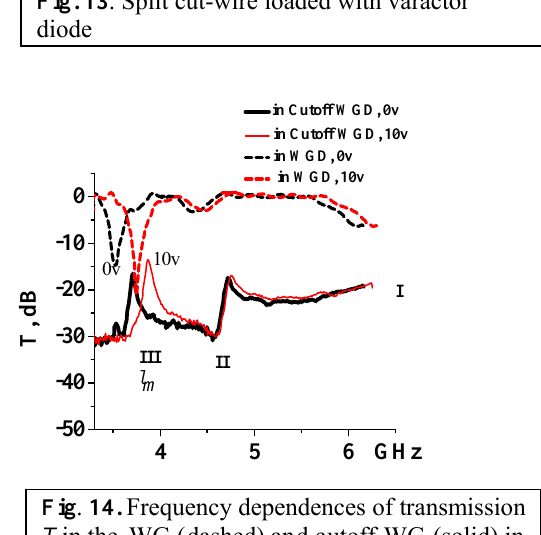
Fig. 13 . Split cut-wire loaded with varactor diode